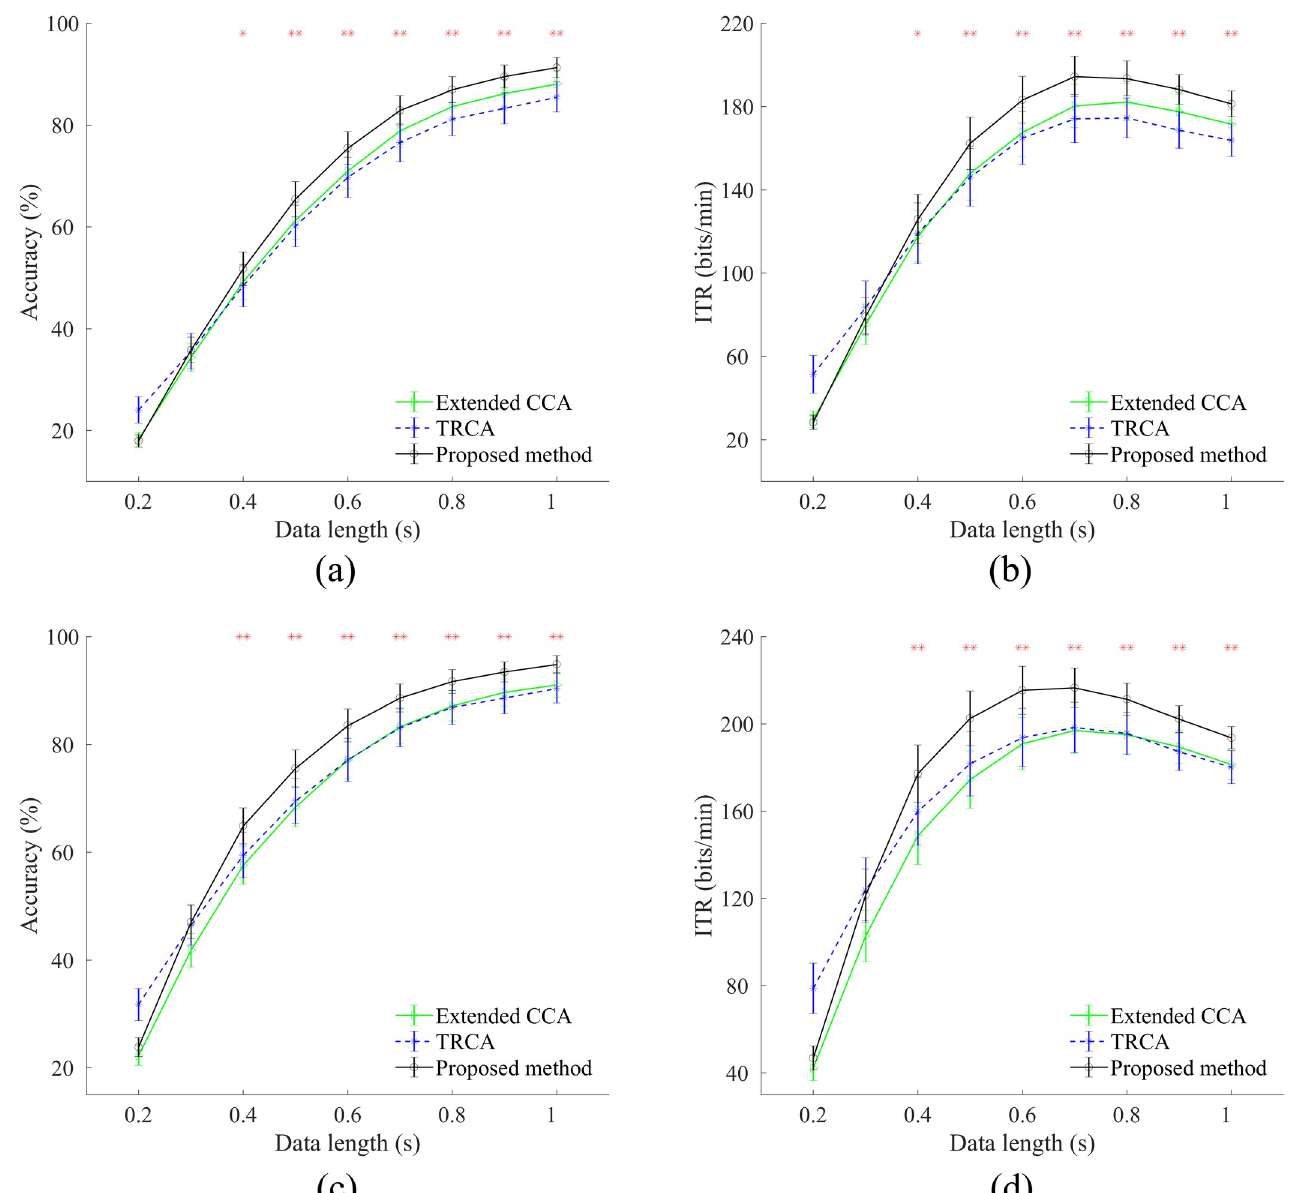
Fig 3. Average accuracies, (a) and (c), and ITRs, (b) and (d), across subjects for three basic methods at different time windows. Results in the first and second rows are derived without and with the filter bank, respectively. Number of sub-bands is set to 4. Asterisks represent significant difference between the three methods, using ANOVA at time windows greater than 0.3 ( � p < 0.01, �� p < 0.001). Error bars show standard